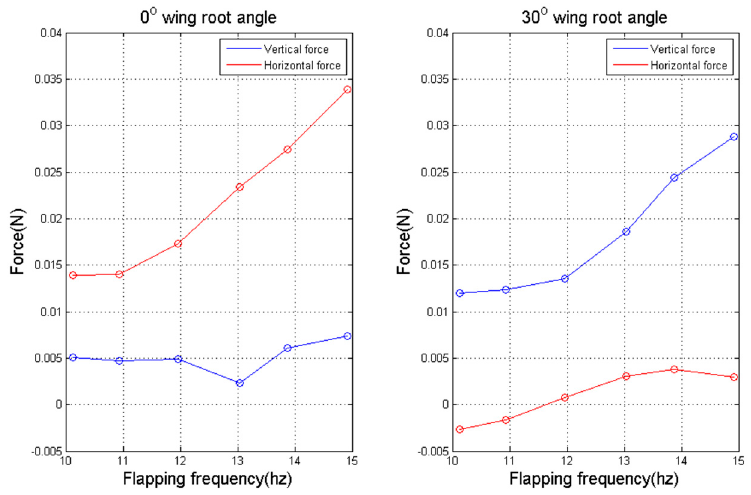
Figure 23. Vertical force and horizontal force with respect to flapping frequency at an inclined stroke angle.